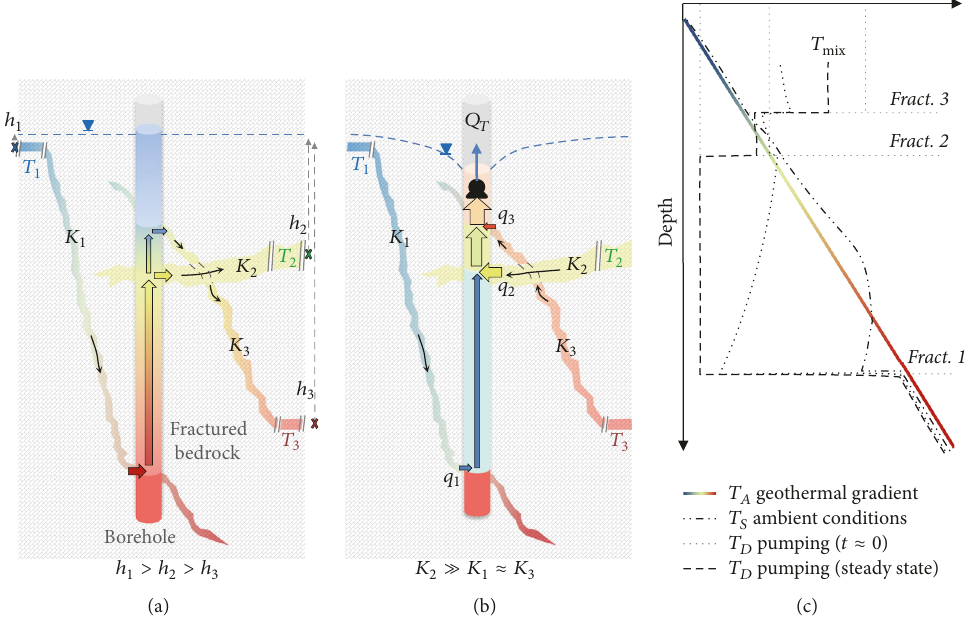
Figure 2: Conceptual schematic of temperature profiles in a fractured aquifer: (a) ambient scenario, (b) pumping scenario, and (c) 𝑇 𝑆 and 𝑇 𝐷 temperature profiles in the